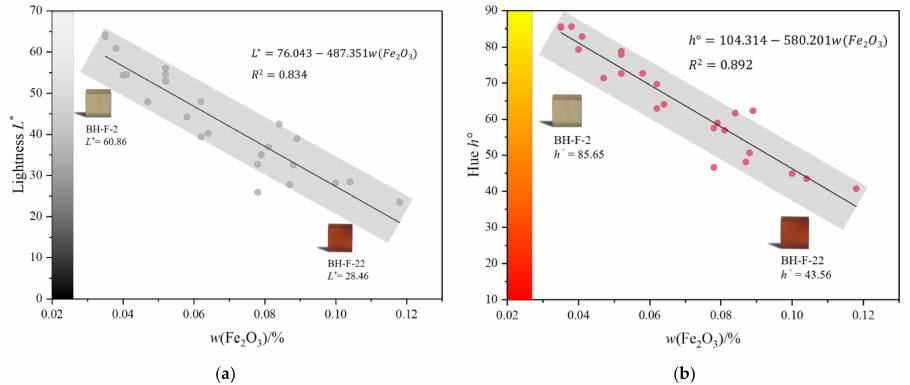
Figure 3. Relationships between colour parameters and total Fe content. ( a ) The higher the total Fe content, the lower the lightness of Beihong agate. ( b ) The change in the total Fe content causes the hue of Beihong agates to vary from yellow to orange-red. The bars on the left of the two figures show the corresponding lightness and hue of different values.